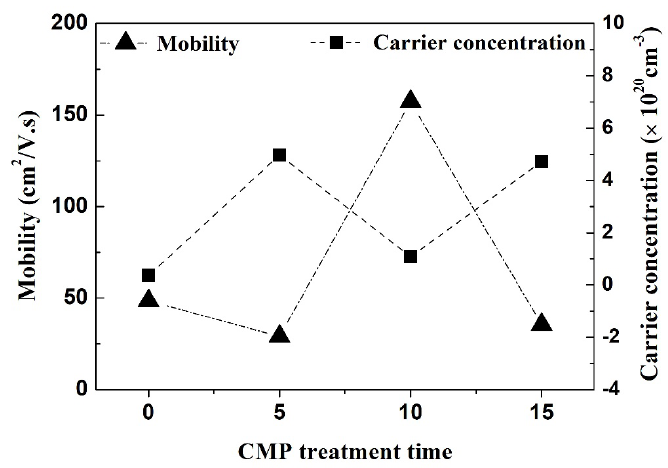
Figure 6. Electrical properties of the FTO substrate as a function of CMP surface treatment time.